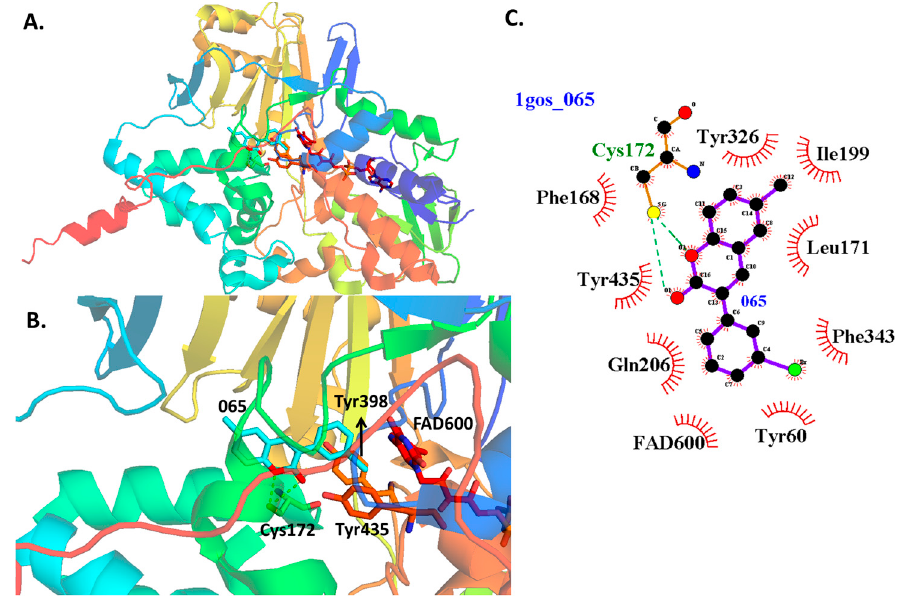
Figure 4. Molecular docking of 3-(3 ′ -bromophenyl)-6-methylcoumarin ( 65 ) on the MAO-B binding pocket. ( A ) 3D overview within the MAO-B active site. ( B ) Best orientation of compound 65 on the MAO-B active site. ( C ) Details of polar, van der Waals and hydrogen bonding interactions established by compound 65 with the residues on the MAO-B active site.